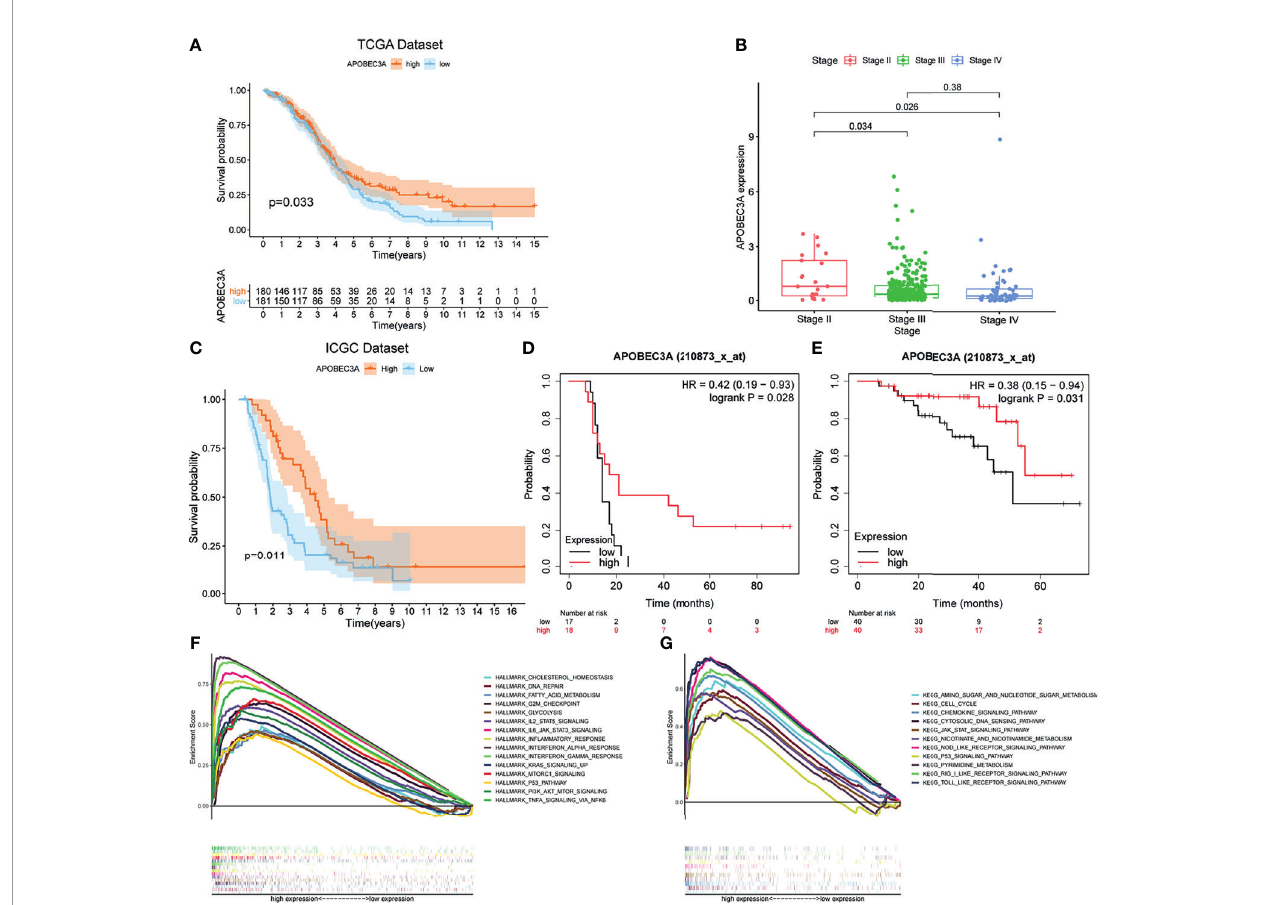
FIGURE 3 | Correlation analysis of APOBEC3A expression with survival and clinicopathological staging characteristics of ovarian cancer (OC) patients. (A) Survival analysis for OC patients with different APOBEC3A expression. Patients were marked with high expression or low expression depending on comparing with the median expression level. p = 0.033 by log-rank test. (B) The correlation of APOBEC3A expression with clinicopathological stage characteristics. Kruskal – Wallis rank sum test acted as the statistical signi fi cance test. (C) The correlation of APOBEC3A expression with survival time from the International Cancer Genome Consortium (ICGC) database in OC patients, by log-rank test. (D, E) The correlation of APOBEC3A expression with survival time using the Kaplan – Meier plotter. (F, G) Enriched gene sets in the HALLMARK and KEGG gene sets, by samples of high APOBEC3A expression. Each line is represented by one particular gene set with unique color, and upregulated genes are located on the left, which approach the origin of the coordinates; by contrast, the downregulated ones lay on the right of the x -axis. Only gene sets with both NOM p < 0.05 and FDR q < 0.05 were considered signi fi cant. Only several top gene sets are shown in the